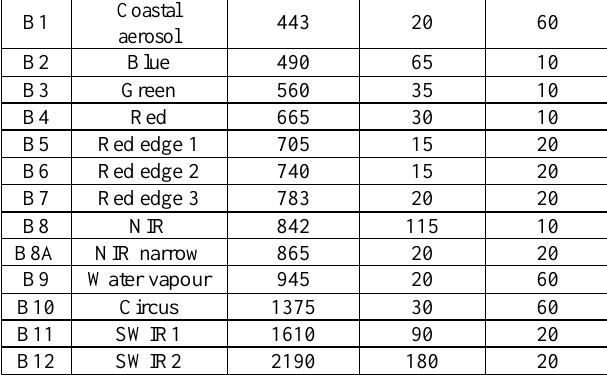
Table 1. Specifications of Sentinel-2 MSI (Multispectral